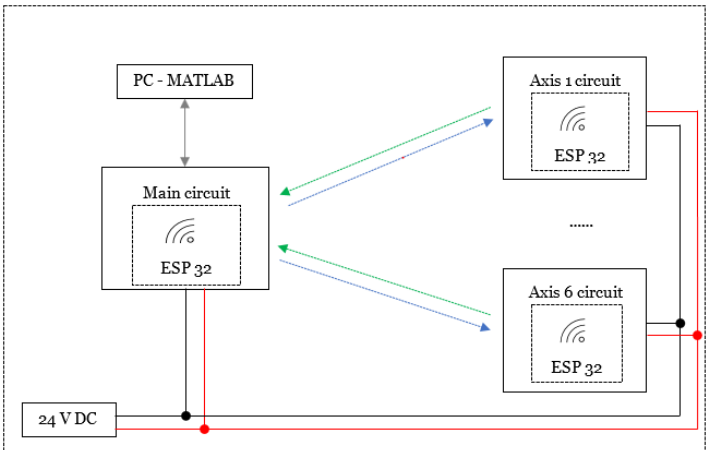
Figure 8. Diagram and typology of communication between ESP32 and PC.